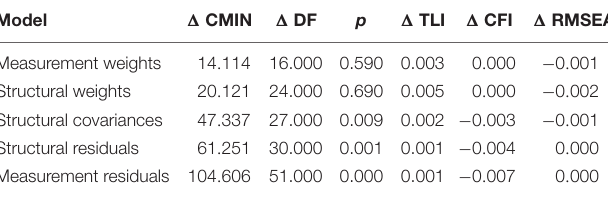
TABLE 8 | Test invariance of multigroup